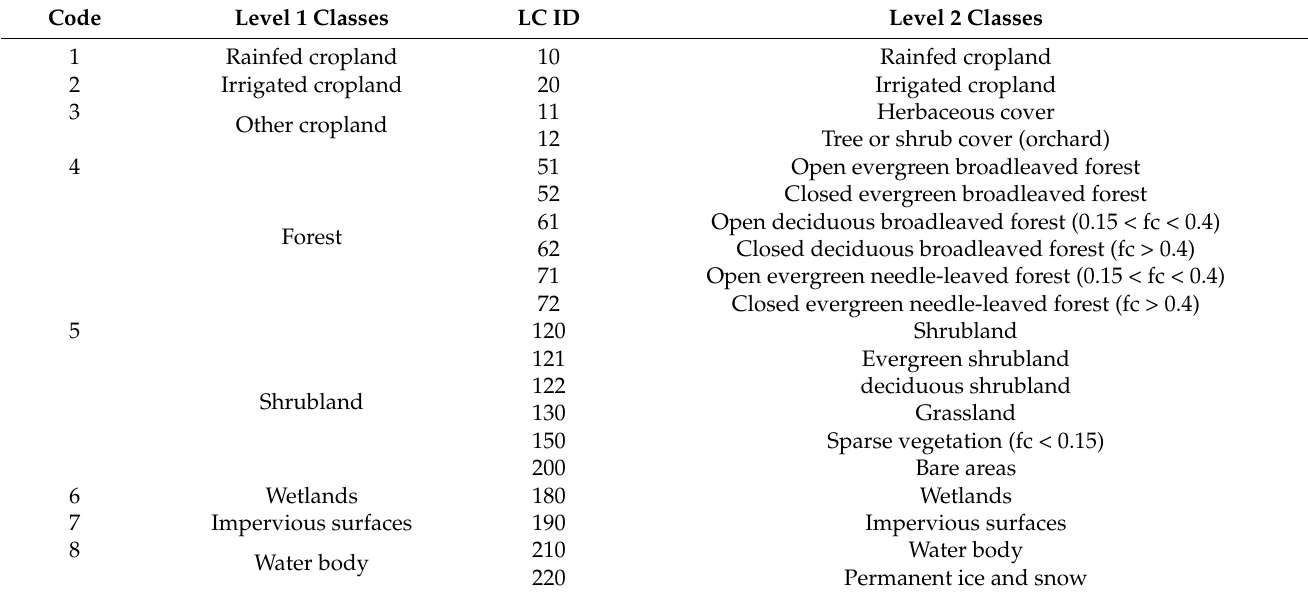
Table 2. Land use/land cover classification system in